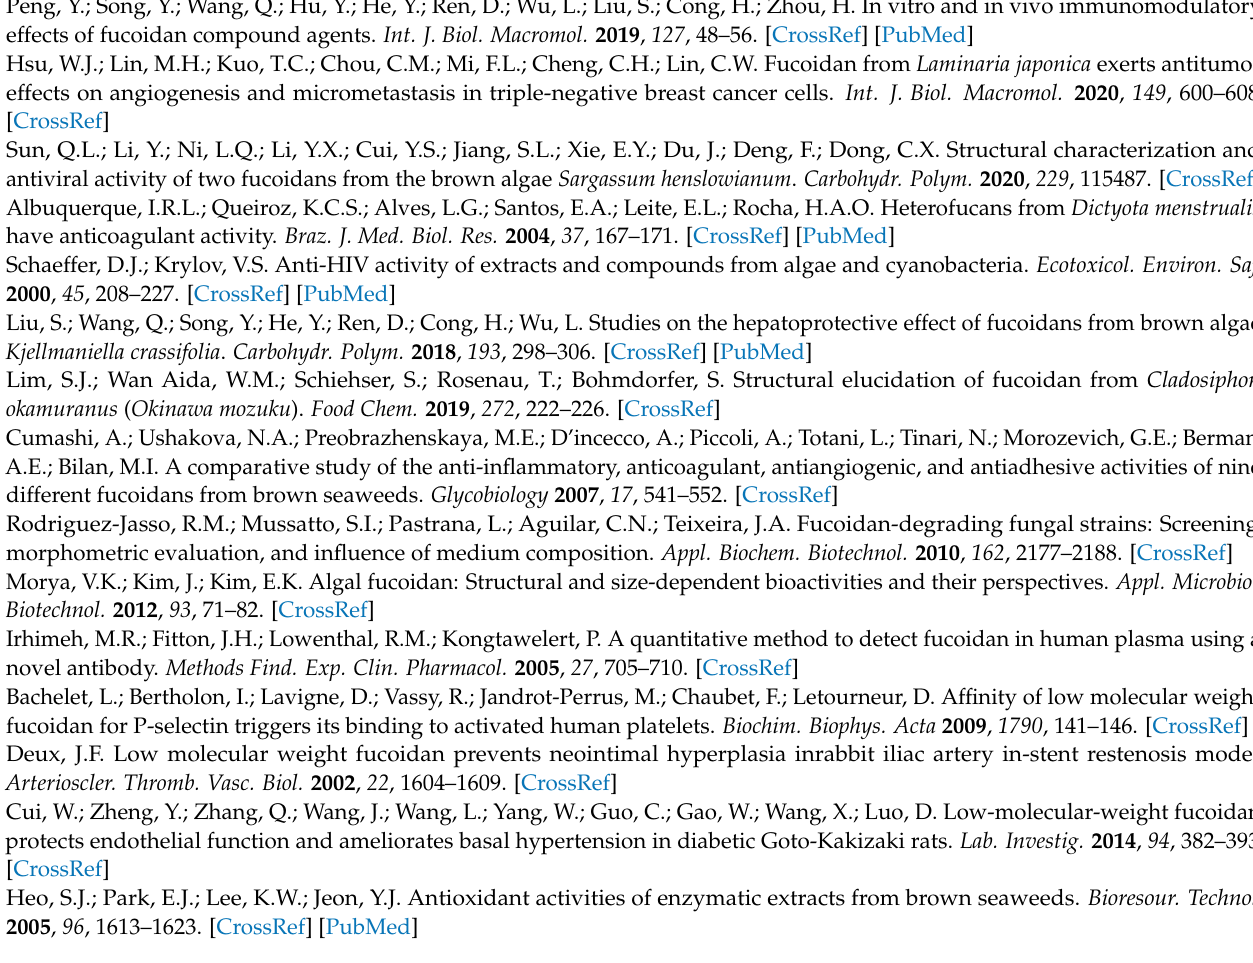
Table S1: Factors of orthogonal experiment; Table S2: The results of L9 (34) orthogonal experiment; Table S3: Verification test results of enzyme activity in two